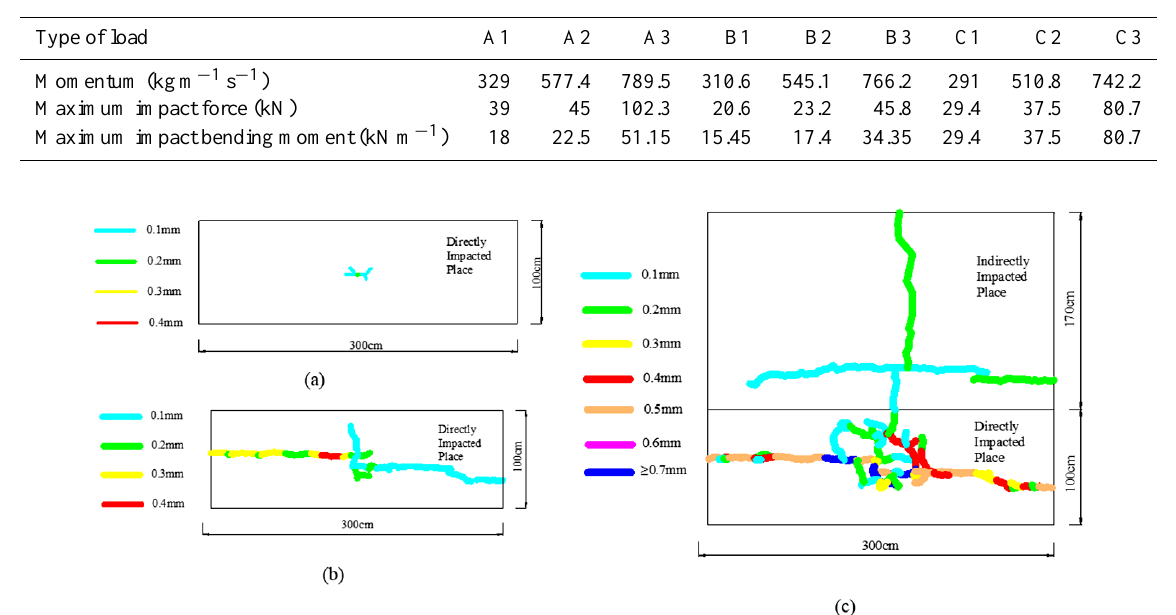
Figure 3. Distribution of the cracks on the element in series A ( a , b and c represent the A1, A2 and A3,